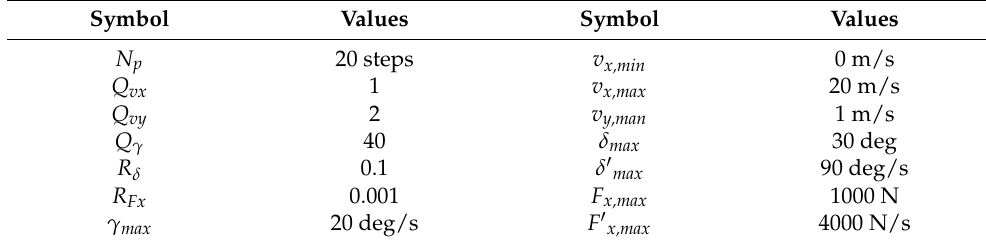
Table 1. Parameters for model predictive control (MPC)-based